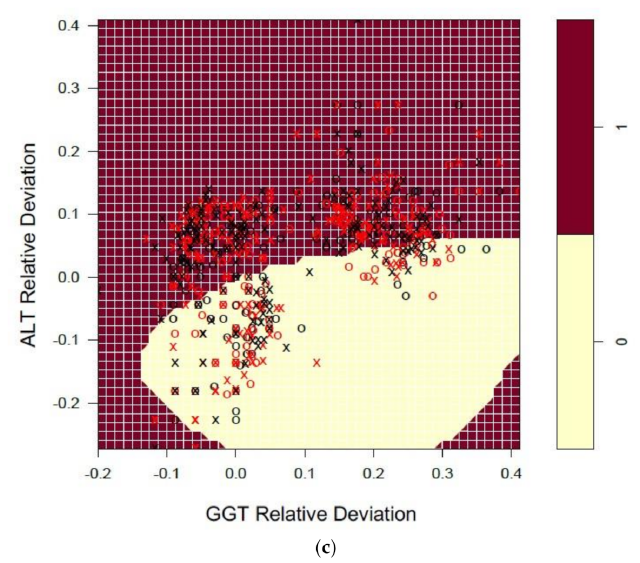
Figure 4. Support vector machine (SVM) plots representing the interactions between the top three EQA Liver Function Test (LFT) predictors of NATA Minor Class Condition reports (High = Red; Low = Yellow). The plots represent ALT and GGT relative deviations on the x-y axes, with SVM slices for AST included at the following relative deviation values: ( a ) − 0.15 ( b ) 0.0 and ( c ) 0.15. The SVM model ran the liver function test relative deviations ALT, AST, Total Bilirubin, GGT, LD and Total Protein (C-classification and radial kernel; Cost = 2, Gamma = 0.25). Model accuracy (10-fold cross validation) –73.01% (65.96–79.17%). X denotes the support vectors (that define the calculated hyperplane required to perform as a classification model). O symbols denote the observations (Red is a class 1 prediction, and Black a class 0